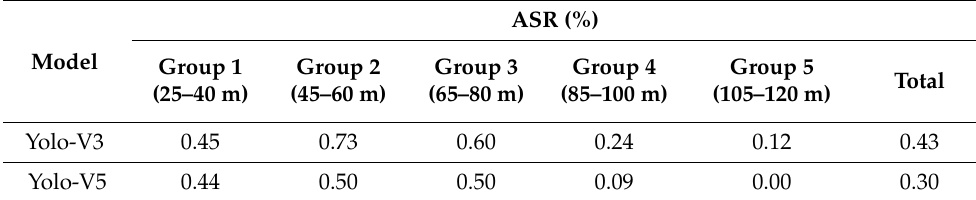
Table 4. Physical attack results on Yolo-V3 and